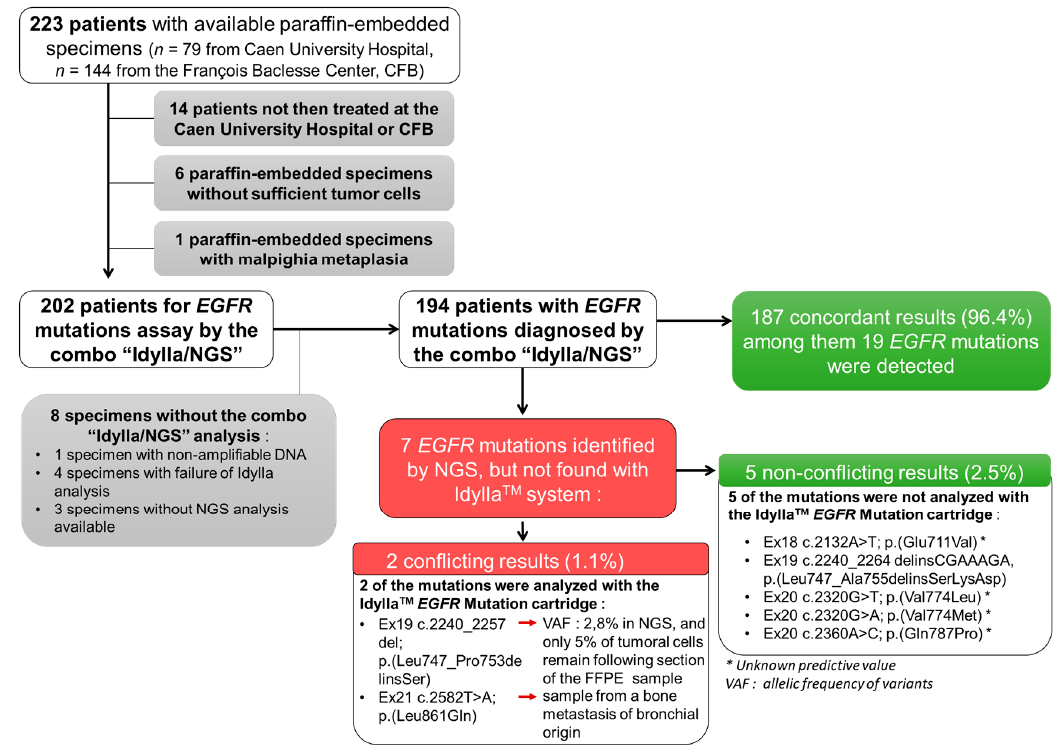
TM system and NGS genotyping for EGFR